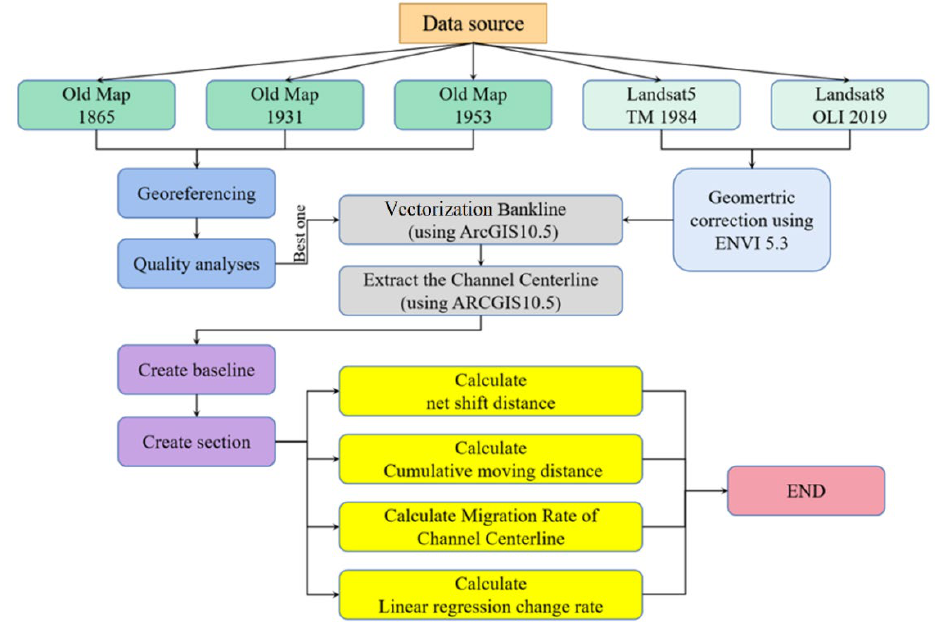
Figure 2. Flowchart of used data and methods.